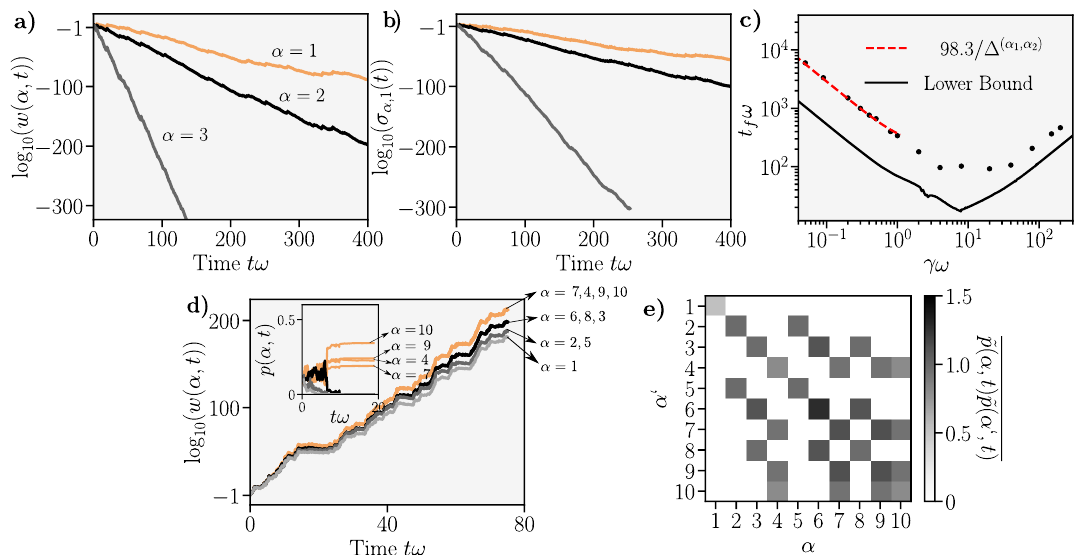
Figure 4: Freezing dynamics for non-interacting bosons collectively coupled to a single-mode electromagnetic field. The Hamiltonian is defined in Eq. (30) and there (cid:112) γ a . We set γ = 5 ω , g = 2 ω , J = 2 ω and the system is a single jump operator L = is always initialised in an equal superposition of random states in each symmetry ) which subspace. The index α runs over the valid momentum tuples ( s , s ,..., s L / 2 1 2 specify the symmetry subspaces, the explicit relationship between α and these tuples is detailed in appendix A. We enforce a maximum photon number in our simulations = 5. In plots a-c) we set L = 4 whilst in plots d-e) we set L = 6. a) Logarithm of n max of the weight of a single trajectory in each of the strong symmetry subspaces verus time, initial state is of the form of Eq. (28). b) Logarithm of the largest singular value of A α ( t ) in each subspace versus time, initial state is of the form of Eq. (28). c) Average freeze-out time on a log-log plot for an initial state of the form of Eq. (27) = 1 and α = 3. Red dashed curve shows 98.3 / ∆ ( α 1 , α 2 ) whilst black solid with α 1 2 line corresponds to the lower bound in Eq. (24). We set ε = 10 − 8 . d) Logarithm of the weight of a single trajectory in each of the strong symmetry subspaces versus time, initial state is of the form of Eq. (28) Inset) Dynamics of the normalised weight for t ω ≤ 40. e) Absolute values of the elements of the matrix ˜ p ( α , t ) ˜ p ( α ′ , t ) for t ω = 250 and averaged over 10 3 trajectories, initial state is the same for all realisa- tions and of the form of Eq.